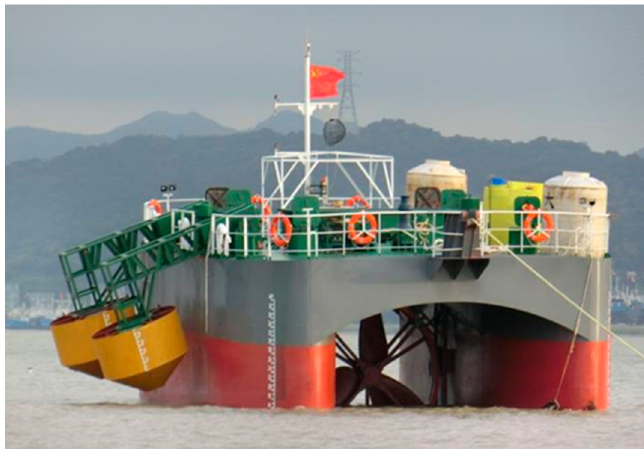
Figure 13. Physical prototype platform of FOECD.